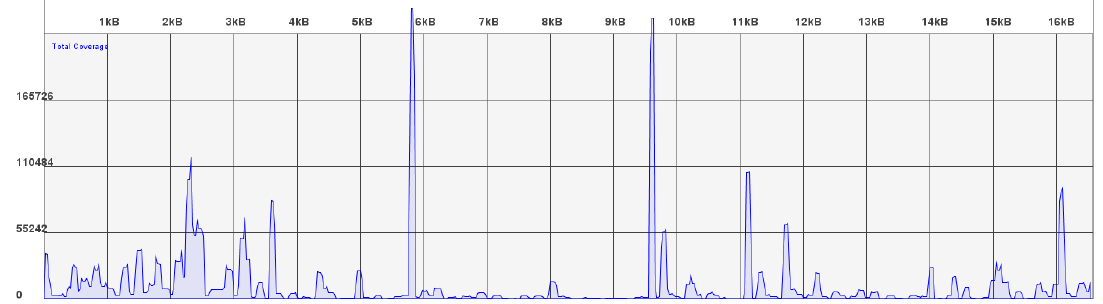
Figure 4. Read coverage for tissue 1. The x-axis shows the mitochondrial genome from position 1 – 16,569. The y-axis represents the number or reads sequenced. The smallest amplicons in the panel are represented in the coverage map by the two spikes just below 6 and 10 kb.